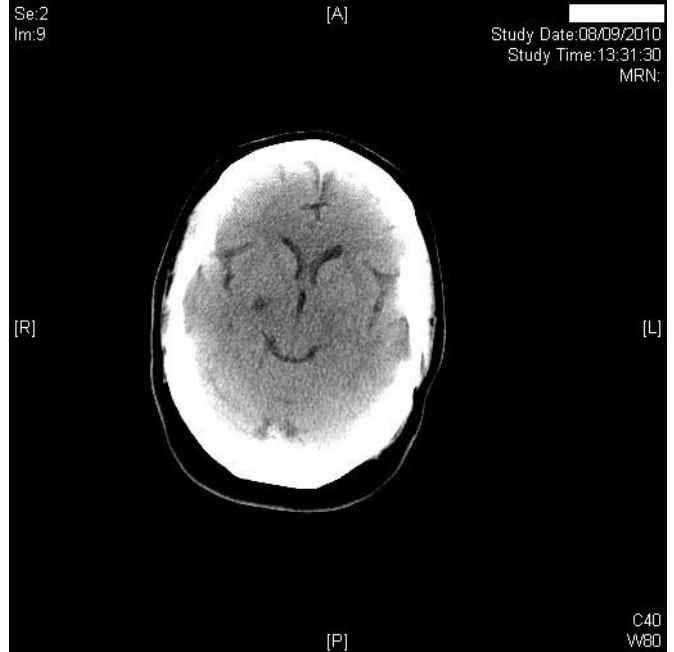
FIGURE 2. CT of the brain, performed on 08 September 2010, revealed a 1.2-cm area of low attenuation noted in the right basal ganglia, which would be in keeping with an infarct. There was no evidence of an intracerebral bleed and no mass